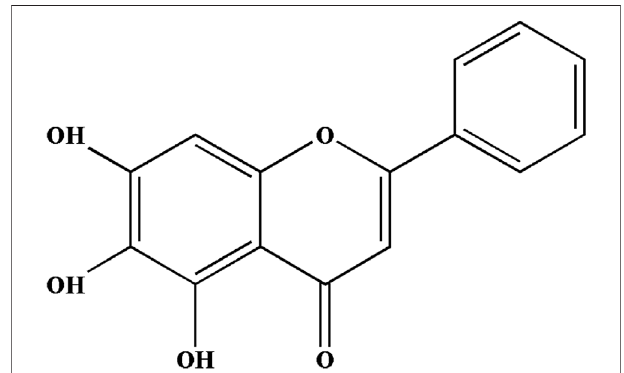
FIGURE 1 | Chemical structure of Baicalein